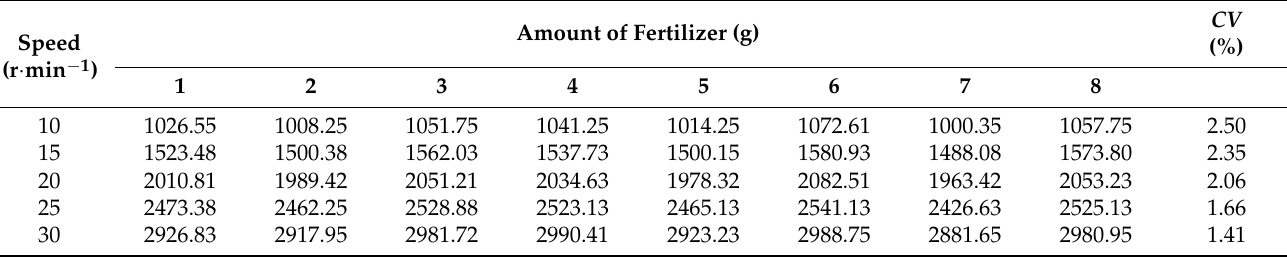
Table 2. Statistical analysis of consistency in the amount of fertilizer in each row.